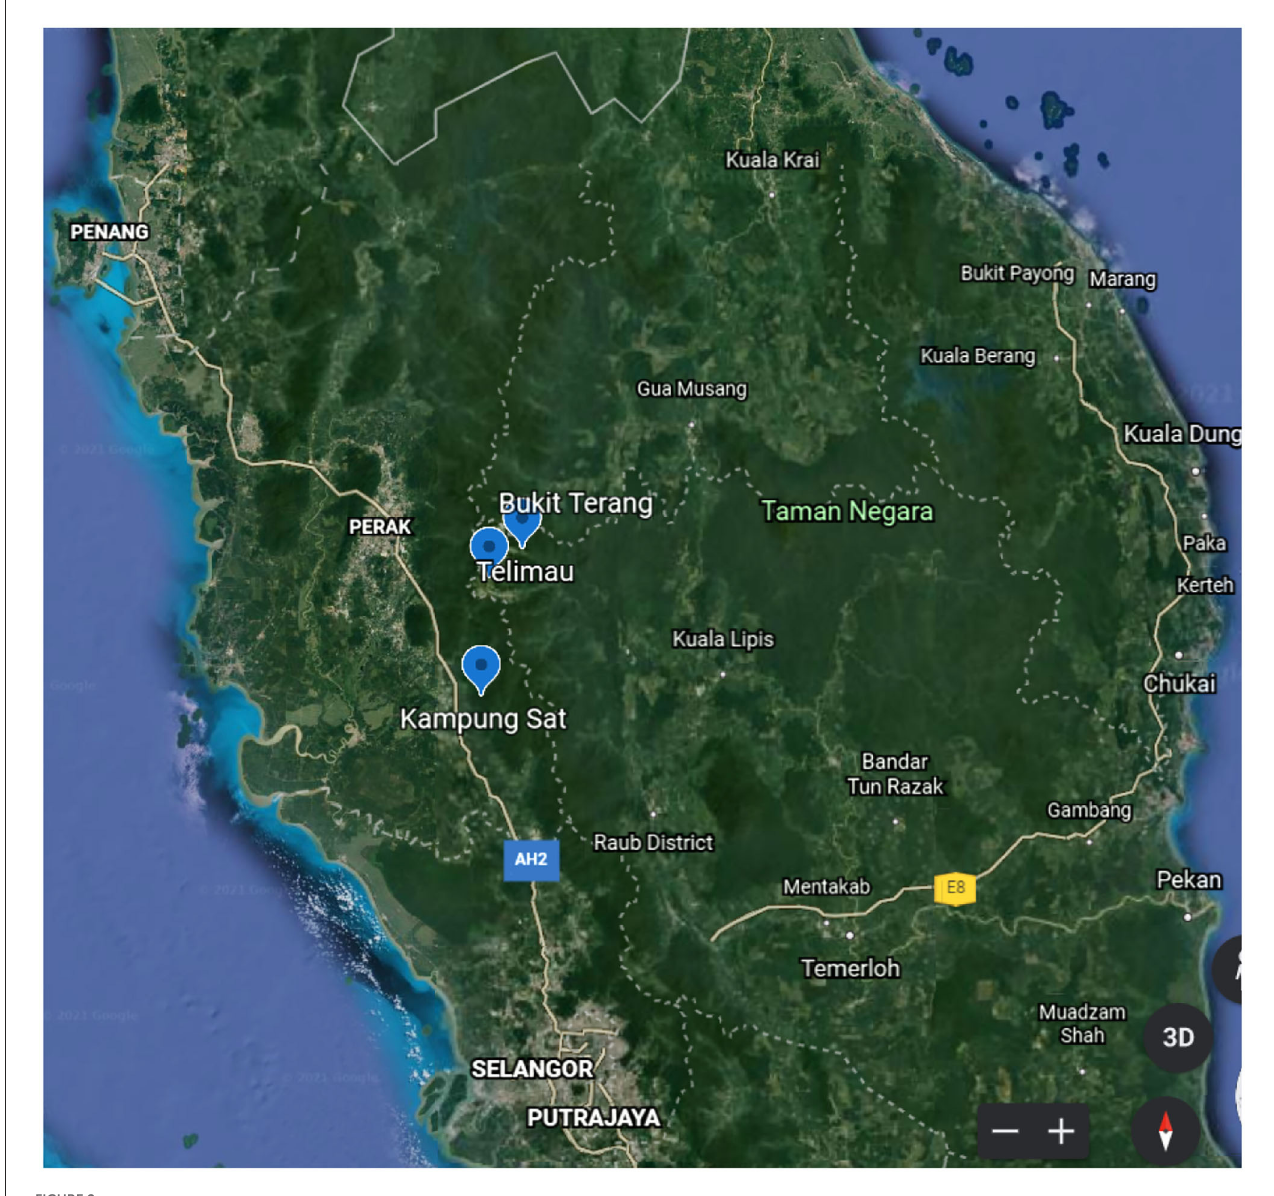
FIGURE2 Map showing the location of Telimau, Bukit Terang, and Kampung